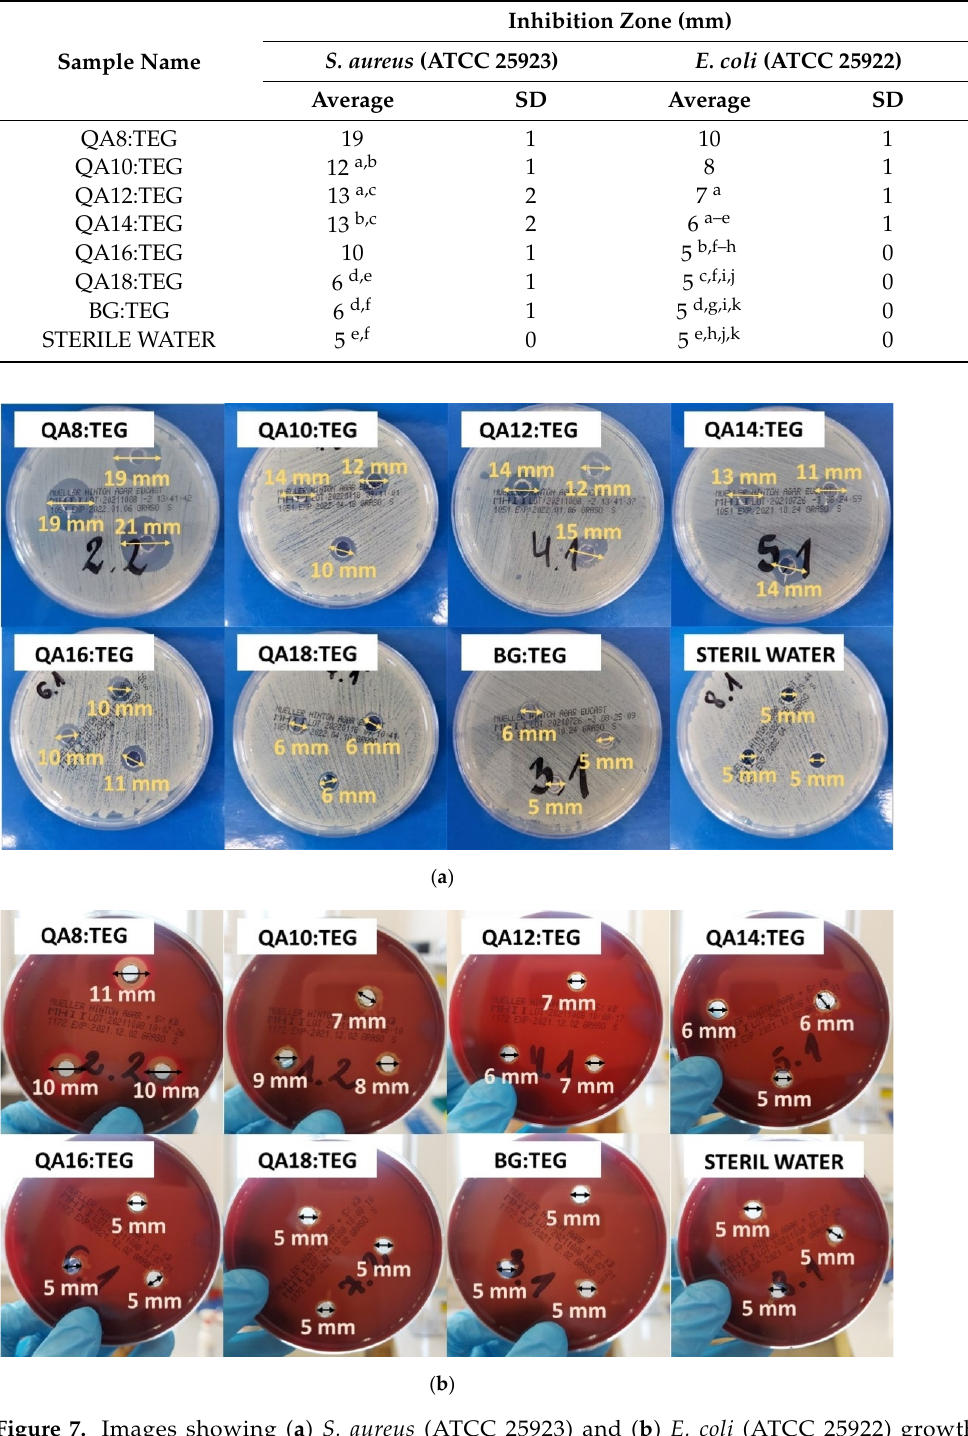
Table 4. S. aureus (ATCC 25923) and E. coli (ATCC 25922) growth inhibition zones. The value of 5